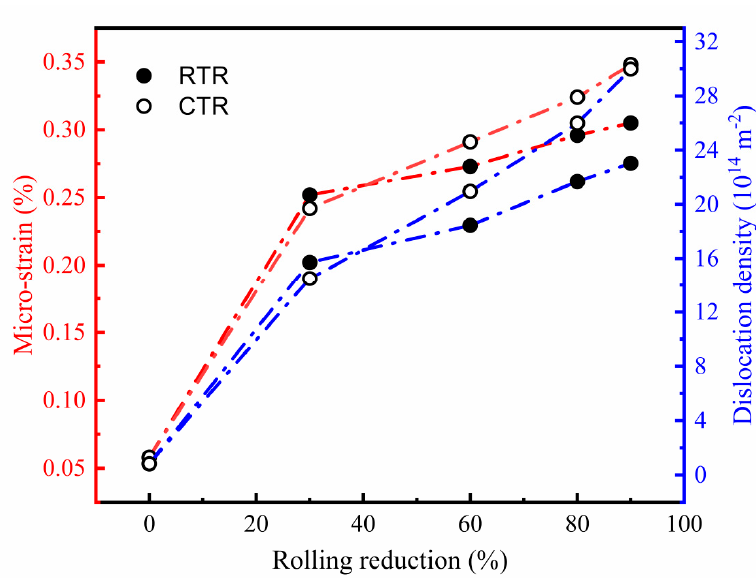
Figure 13. Variation of micro-strain and dislocation density after different rolling